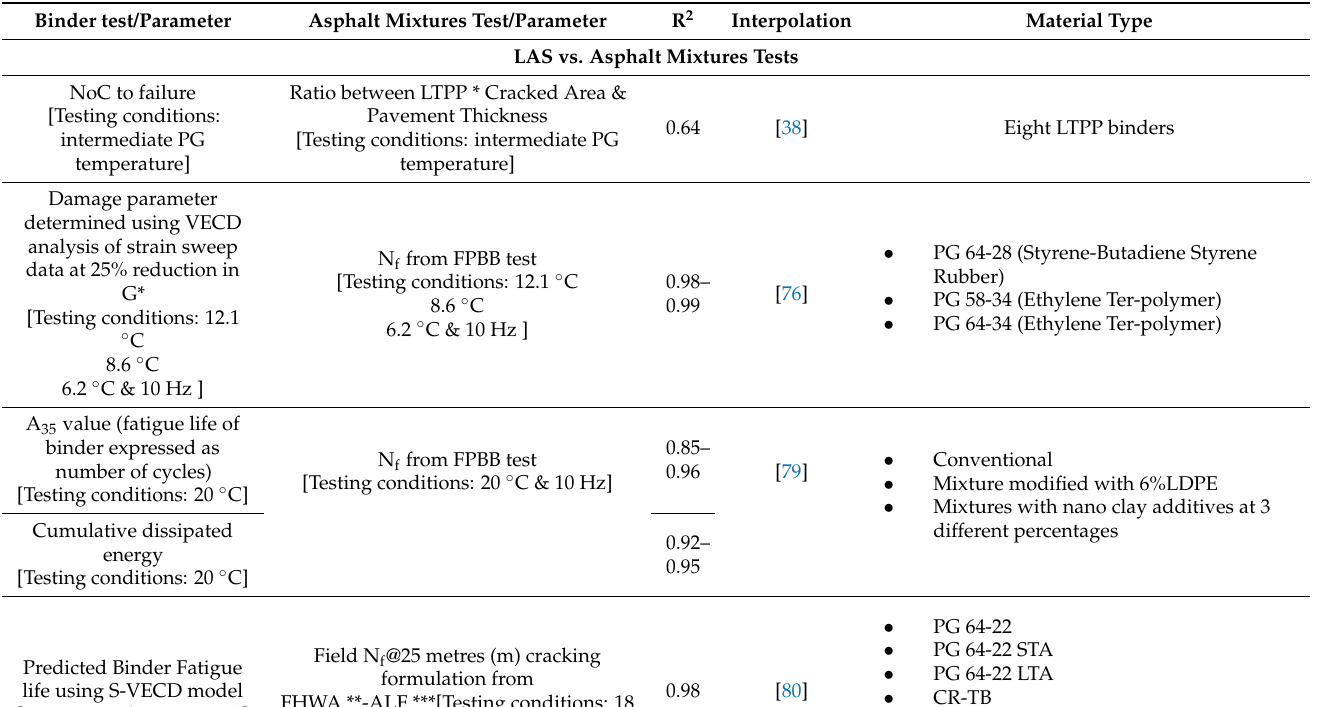
Table 5. Correlations between the properties of the bitumen from LAS tests and cracking properties of asphalt mixtures from various